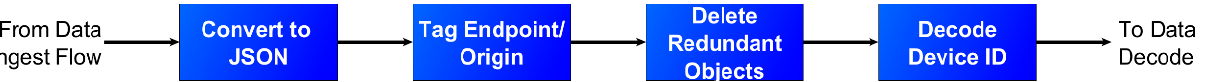
Figure A4. Data flow for the payload sanitizing step of device data integration.